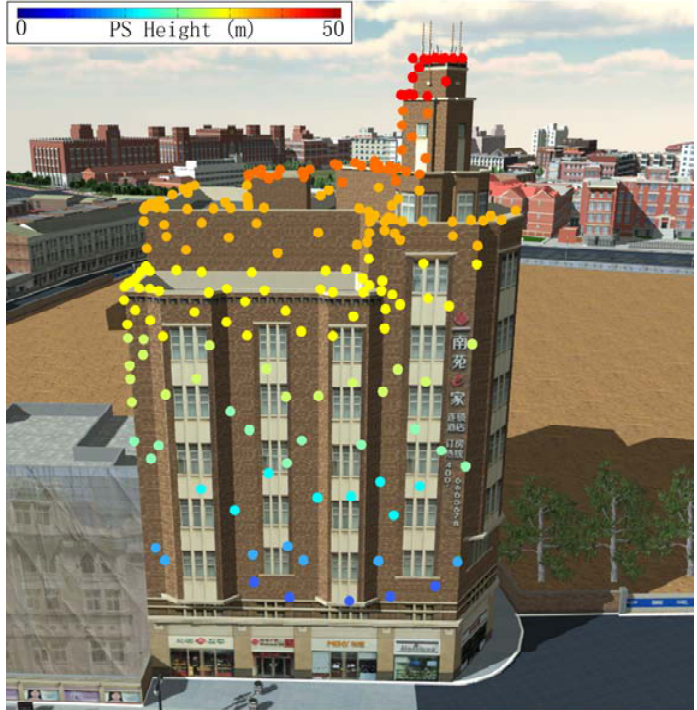
Figure 3. Three ‐ dimensional representations of extracted Permanent Scatterer (PS) point geocoded on precise 3D models for the Bohai Building. All the PS satisfying the stability criteria during IPTA processing (sub ‐ correlation coefficient larger than 0.35 and amplitude deviation measure larger than 1.4) have been located on roof and facades toward the satellite, in the monitoring period from May to December 2014.